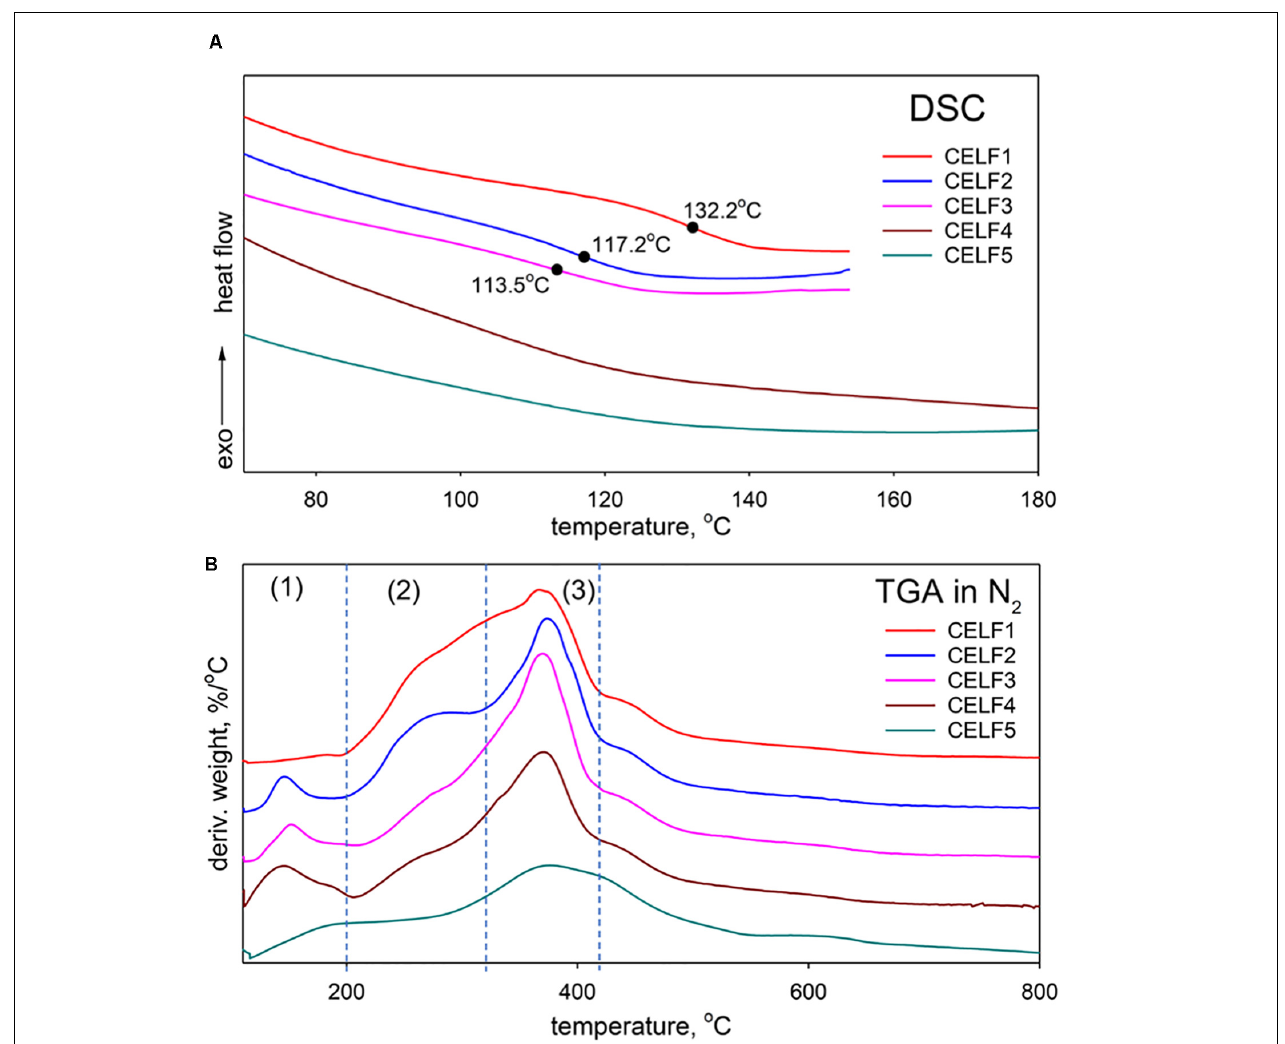
FIGURE 5 | (A) DSC and (B) TGA analyses of CELF lignin samples obtained under different pretreatment conditions.